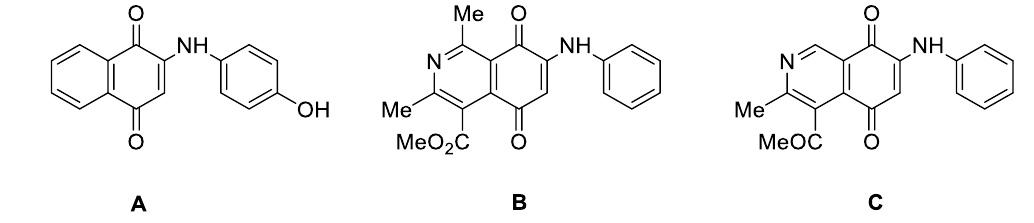
Figure 1. Examples of cytotoxic anilino-1,4-naphthoquinone and hetero-analogues.